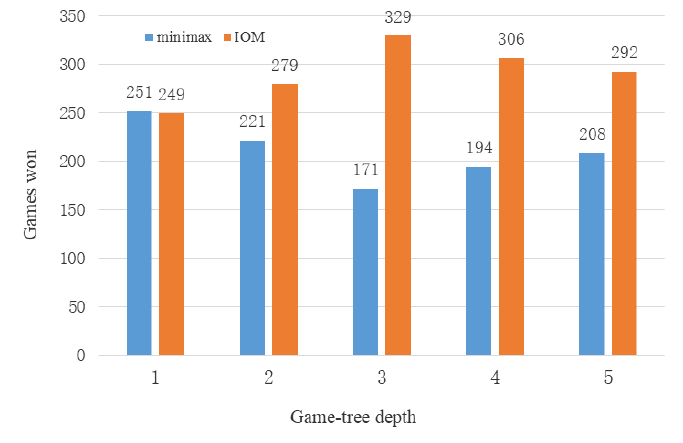
Figure 10. The experimental results for IOM vs. minimax in